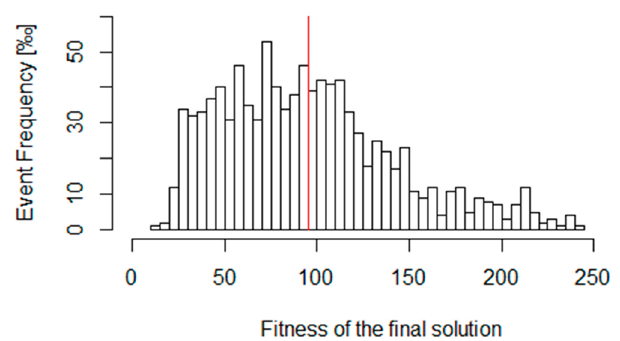
Figure 13. Histogram of the performance of the FLCGA approach. Each value added to the histogram corresponds to the final fitness value obtained for each subsystem.